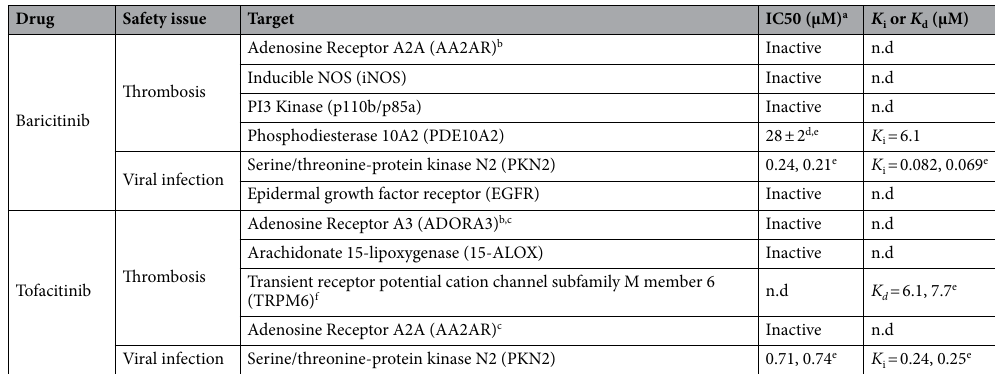
Table 2. In vitro findings for baricitinib and tofacitinib off-target activity. All in vitro testing was performed on a fee-for-service basis at Eurofins Cerep (www. eurofi ns. com). n.d: not determined. a JAK inhibitors were tested at a concentration of 30 μM. During follow-up experiments, JAK inhibitors were tested in multiple concentrations (top concentration of 100 μM) for dose–response curve characterization and determination IC 50 /EC 50 (two or three replicates). b Antagonistic effect. c Agonistic effect. d Values are the mean ± standard error of the mean (SEM) for the number of replicates ( n ) > 2. e For n = 2, no averaging was made, and both values are presented. f Commercial assays were unavailable for TRPC6 or TRPC3, and therefore, these targets could not be validated. Instead, transient receptor potential cation channel subfamily M member 6 (TRPM6) was employed for the respective binding